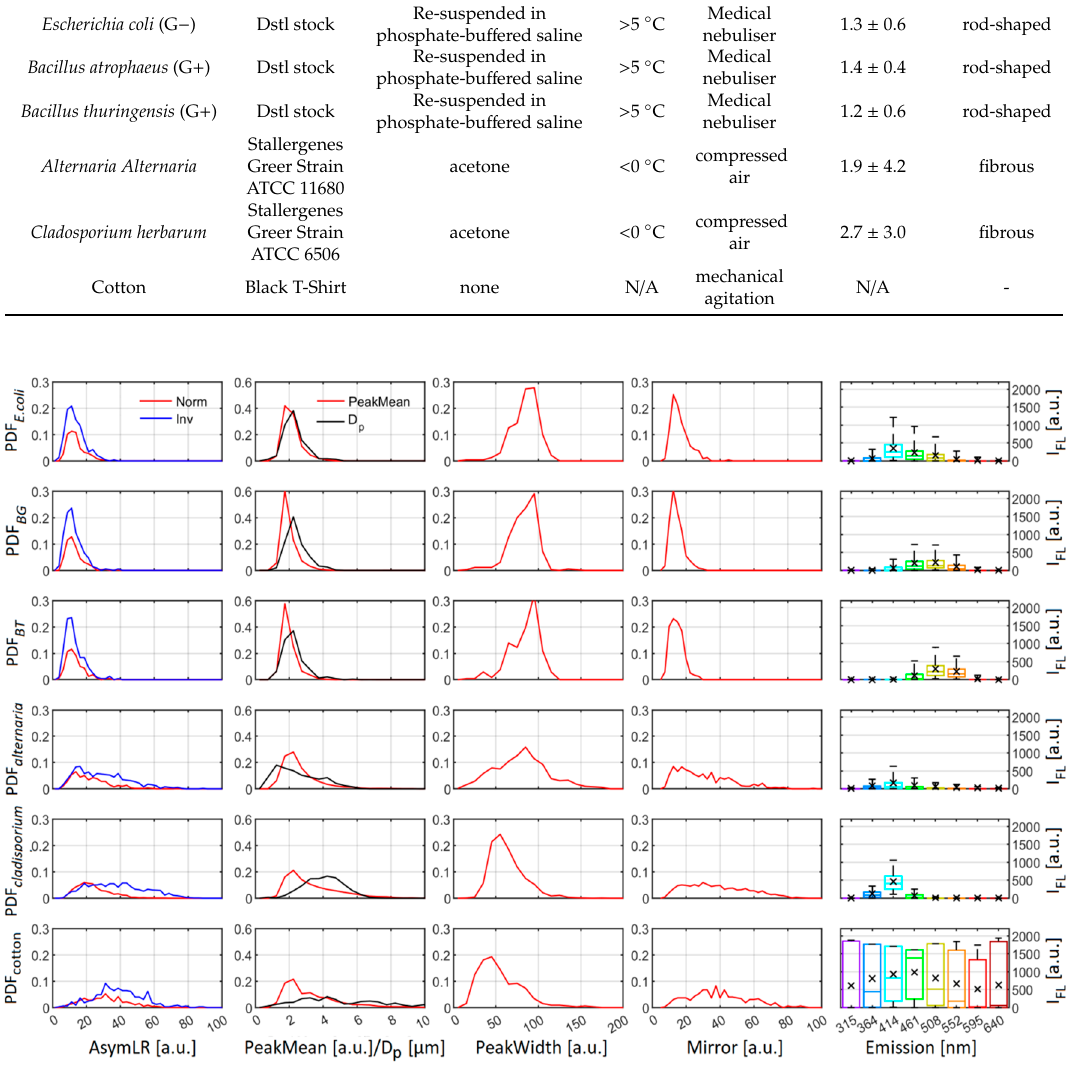
Figure 2. ACS training data overview. Shown are the probability density functions of the CMOS parameters (columns 1 to 4) and box and whisker plots of the autofluorescent spectrum (row 5) for E.coli (top row); Bacillus atrophaeus (BG, 2nd row); Bacillus thuringensis (BT, 3rd row); Altenaria (4th row); Cladisporium (5th row); and cotton fibres (6th row). Whiskers denote 5th and 95th percentiles. Cross denotes mean value.